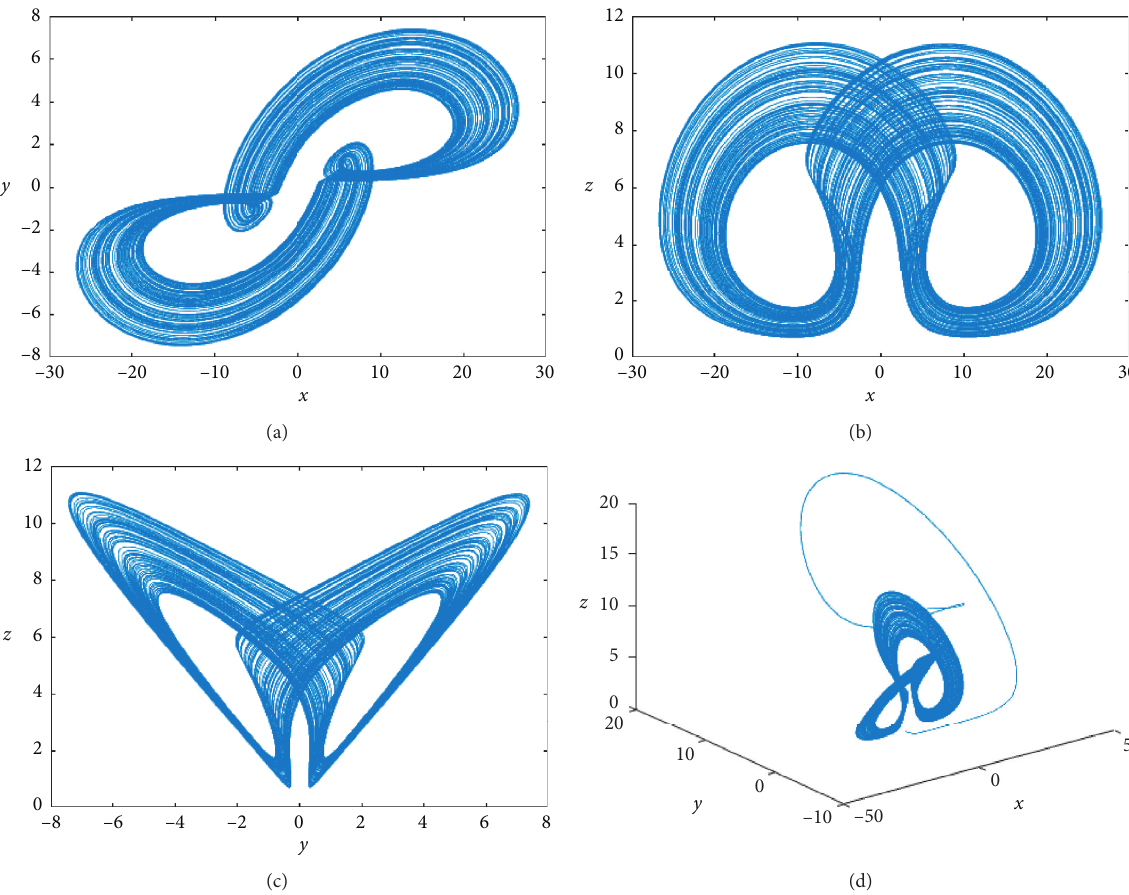
Figure 1: Phase portraits of system (2) when a � 4, b � 6, c � 20, d � 5, e � 0 . 01, f � 1, 3 g � 0 . 1, and h � 0 . 1: (a) projection on x − y plane, (b) projection on x − z plane, (c) projection on y − z plane, and (d) 3D view in the x − y − z